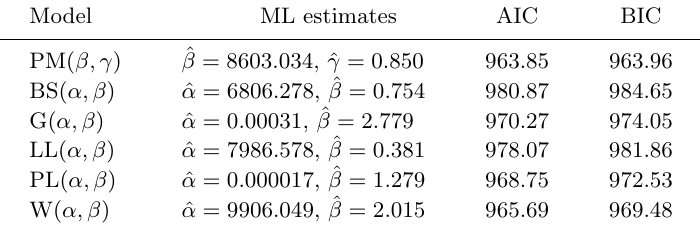
Table 4. Stress-rupture life: Model, ML estimates, AIC and BIC values. Model ML estimates AIC BIC PM( β, γ ) 963.85 963.96 980.87